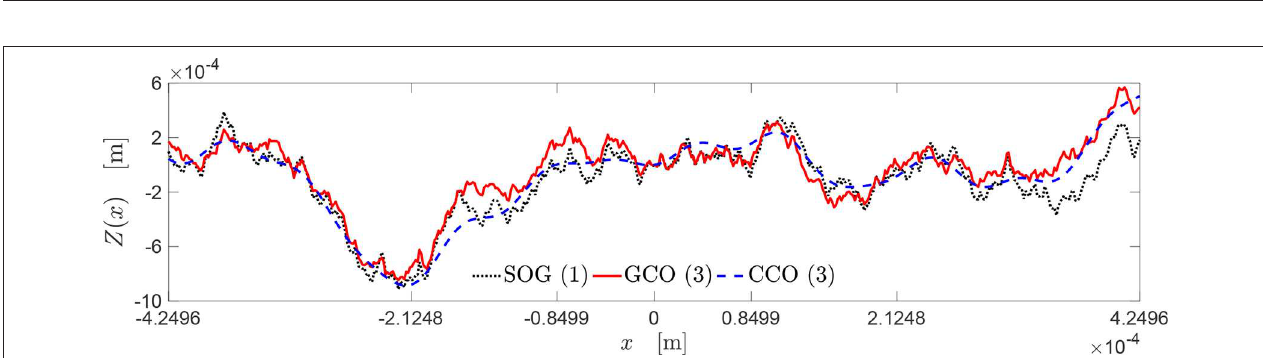
FIGURE 10 | Topography of the best rough profiles approximating the target curve y t (see Figure 9